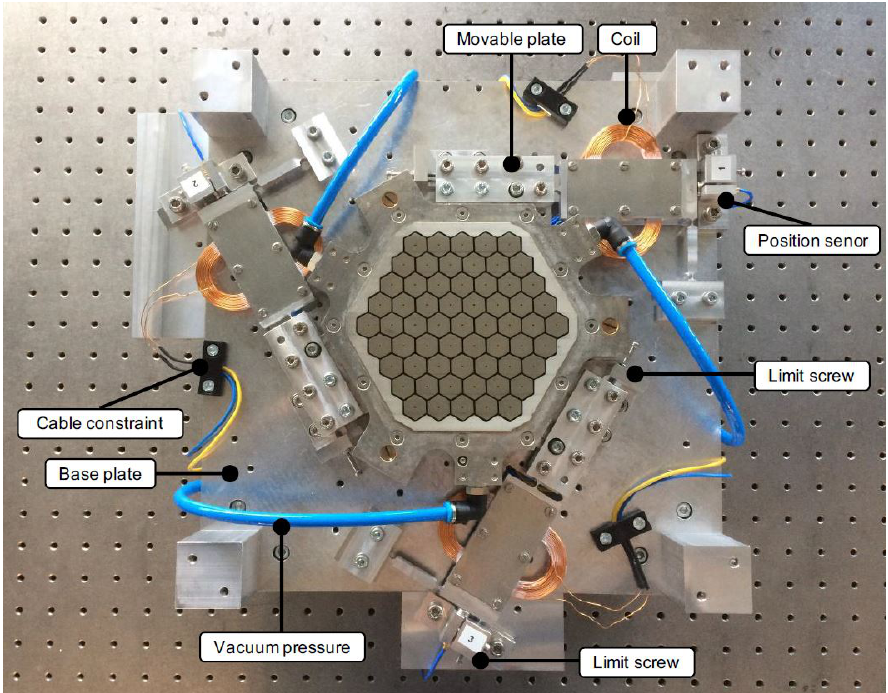
Figure 10. Photograph of the Flowerbed with the compliant mechanism and Lorentz actuator design